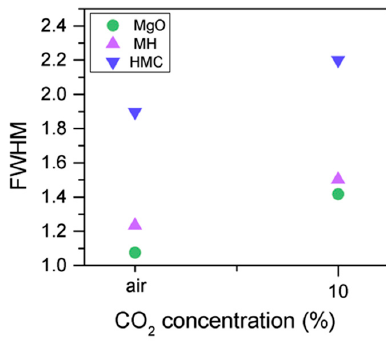
Figure 10. O1s FWHM for samples exposed to air and CO 2 for seven days.